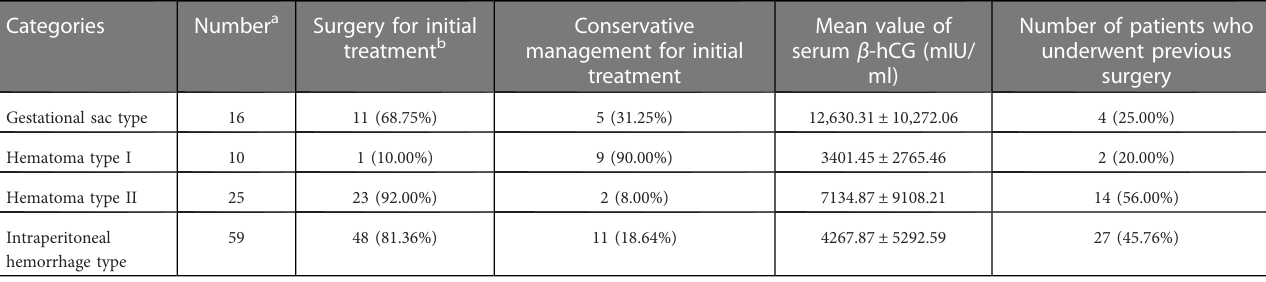
TABLE 1 Cases involving different treatment methods, serum β -hCG levels and characteristics of previous surgeries of four categories of ultrasonographic manifestations.